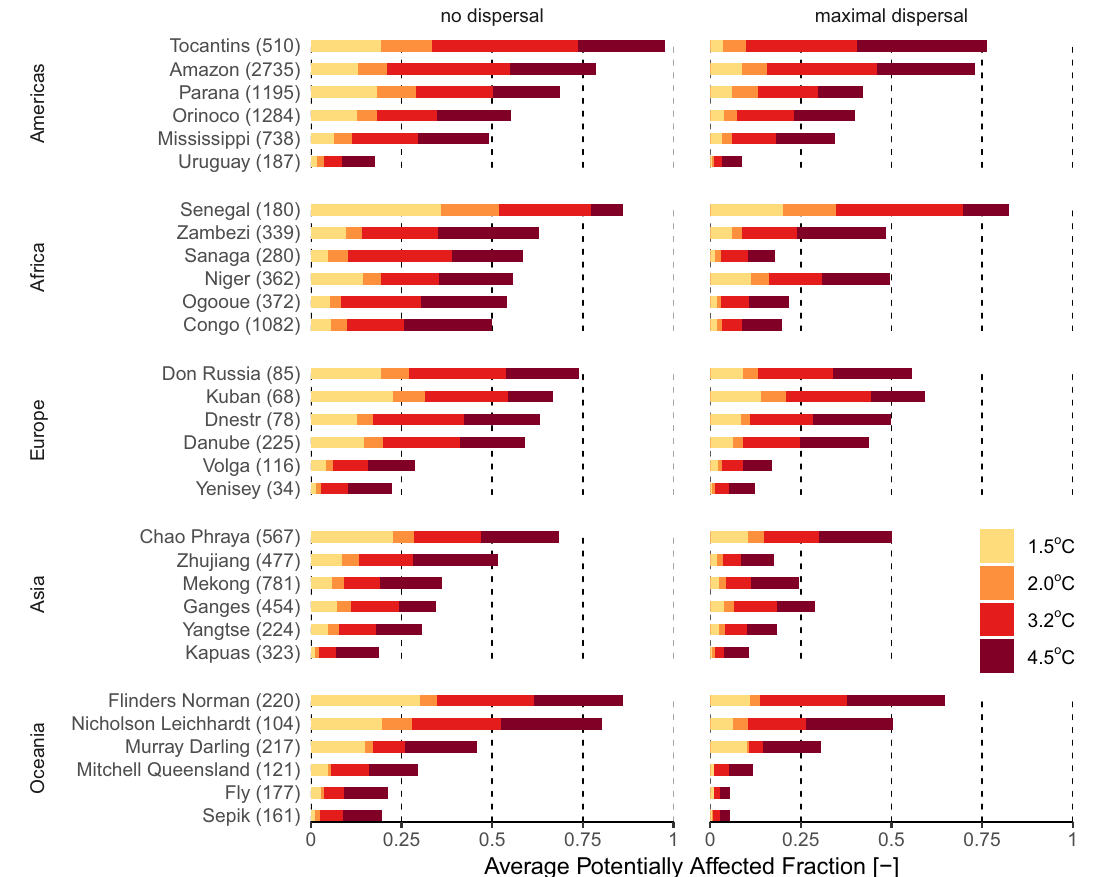
Fig. 3 Climate change threats in large watersheds. Potentially affected fraction of species averaged across 5 arcminutes grid cells within 30 large watersheds, for four warming levels and two dispersal assumptions. For each continent de fi ned according to the World Bank Development Indicators (www.worldbank.org), we selected the six watersheds with the largest numbers of species and covering at least 50% of the known species richness (according to Tedesco et al. 2 ). A more exhaustive overview of 200 watersheds is available in Supplementary Fig. 4. Numbers in brackets represent the number of species within the watershed. Source data are provided as Supplementary Data